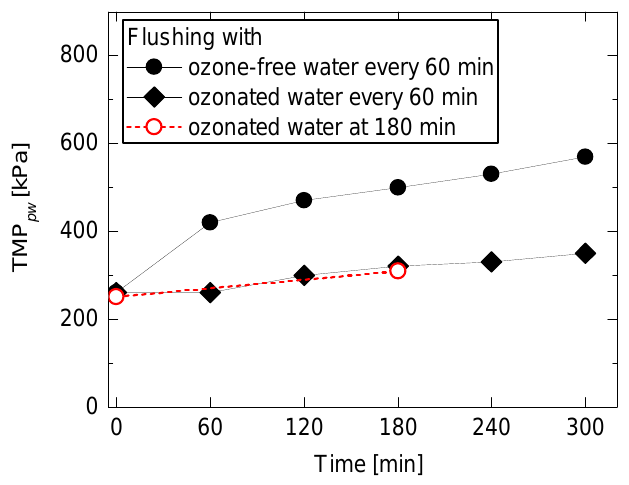
Figure 7. TMP pw at the beginning of each filtration cycle (permeate flux = 44 L/m 2 h, feed water temperature = 20 °C, cross ‐ flow velocity = 0.43 m/s).